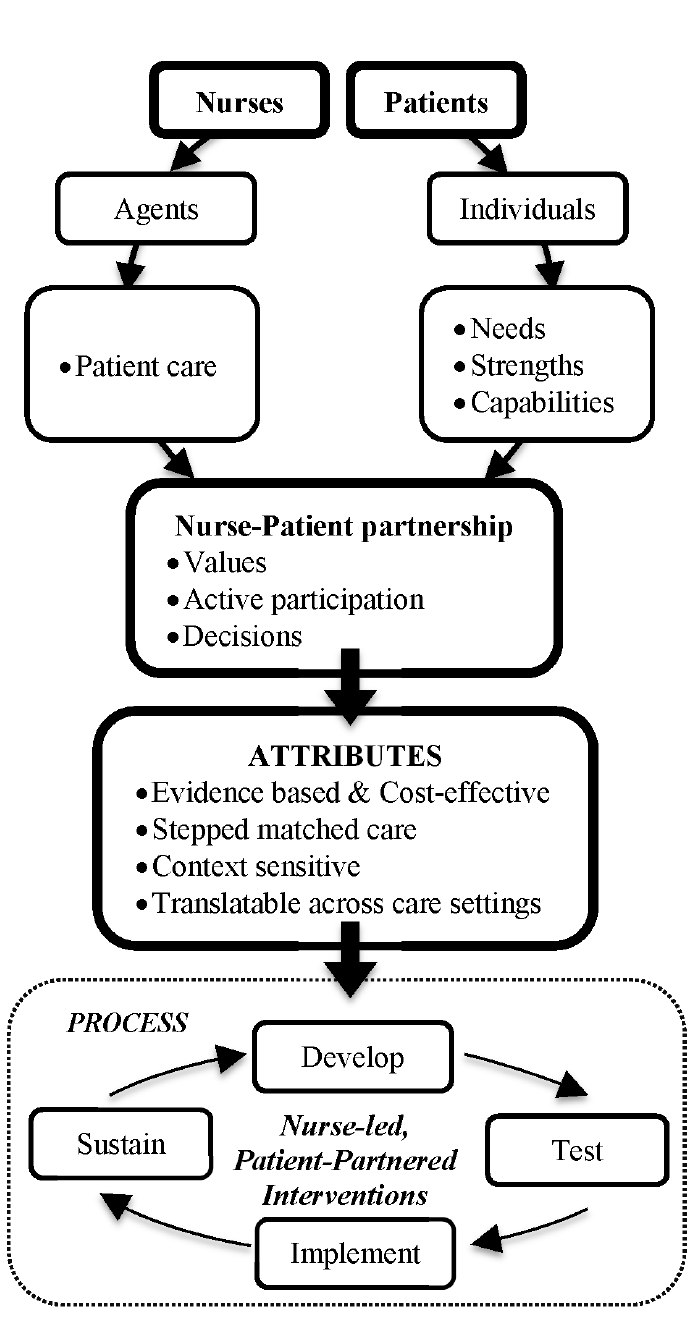
Figure 1. The partnering with patients model of nursing